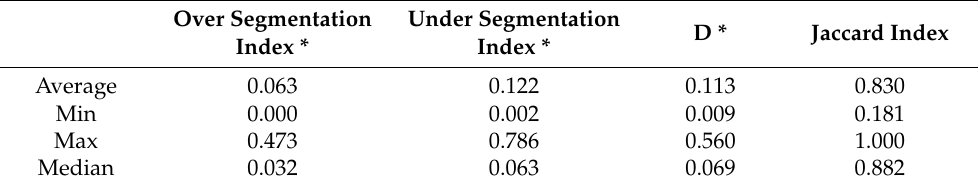
Table 6. Area-based quantitative assessment of the segmentation of the buildings in the Niger case study. * Lower values means better segmentation.